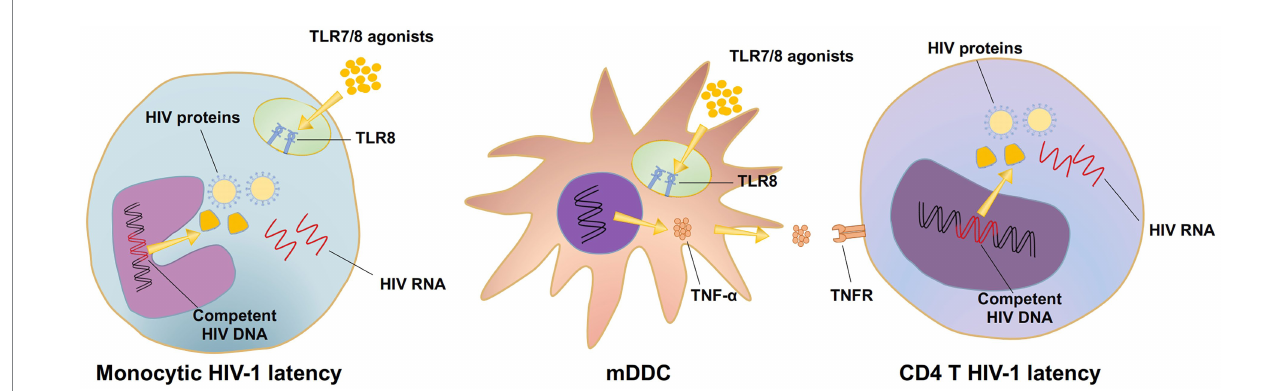
FIGURE 7 The mechanism diagram of TLR7/8 agonists activating HIV latent